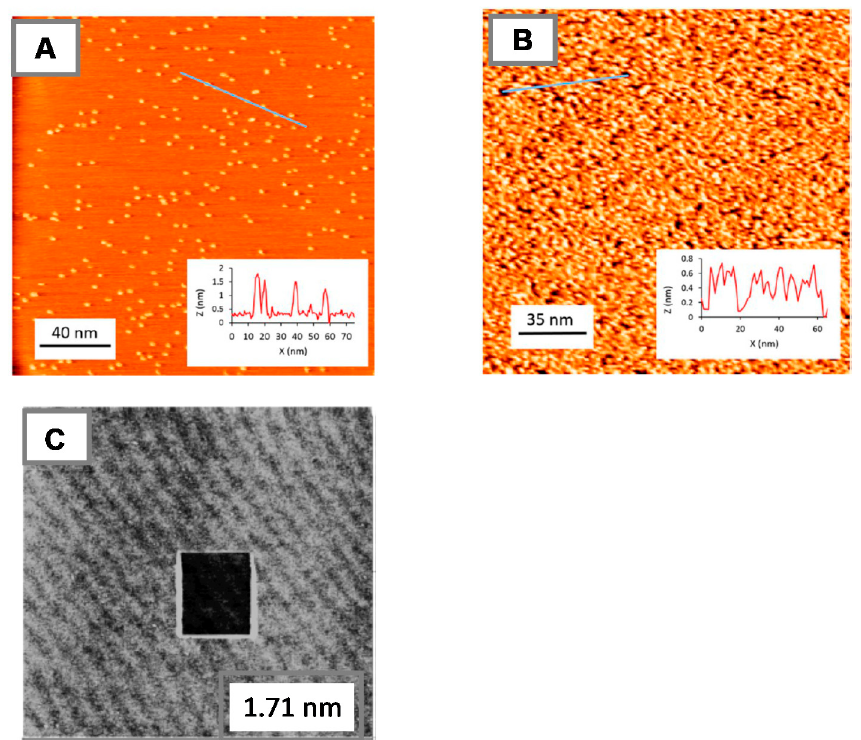
Figure 10. ( A , B ) STM (scanning tunneling microscopy) images of films obtained on highly oriented pyrolytic graphite (HOPG) after spontaneous grafting of ( A ) 4-nitrobenzenediazonium and ( B ) 3,5-bis- tert -butylbenzenediazonium salts. ( C ) AFM (atomic force microscopy) image of a monolayer obtained from 4-nitrobiphenyldiazonium salt (l = 1.21 nm) on PPF, a near-atomically flat carbon; in the black square, the layer was erased by AFM scratching. From References [57,58] with permission of the American Chemical Society.